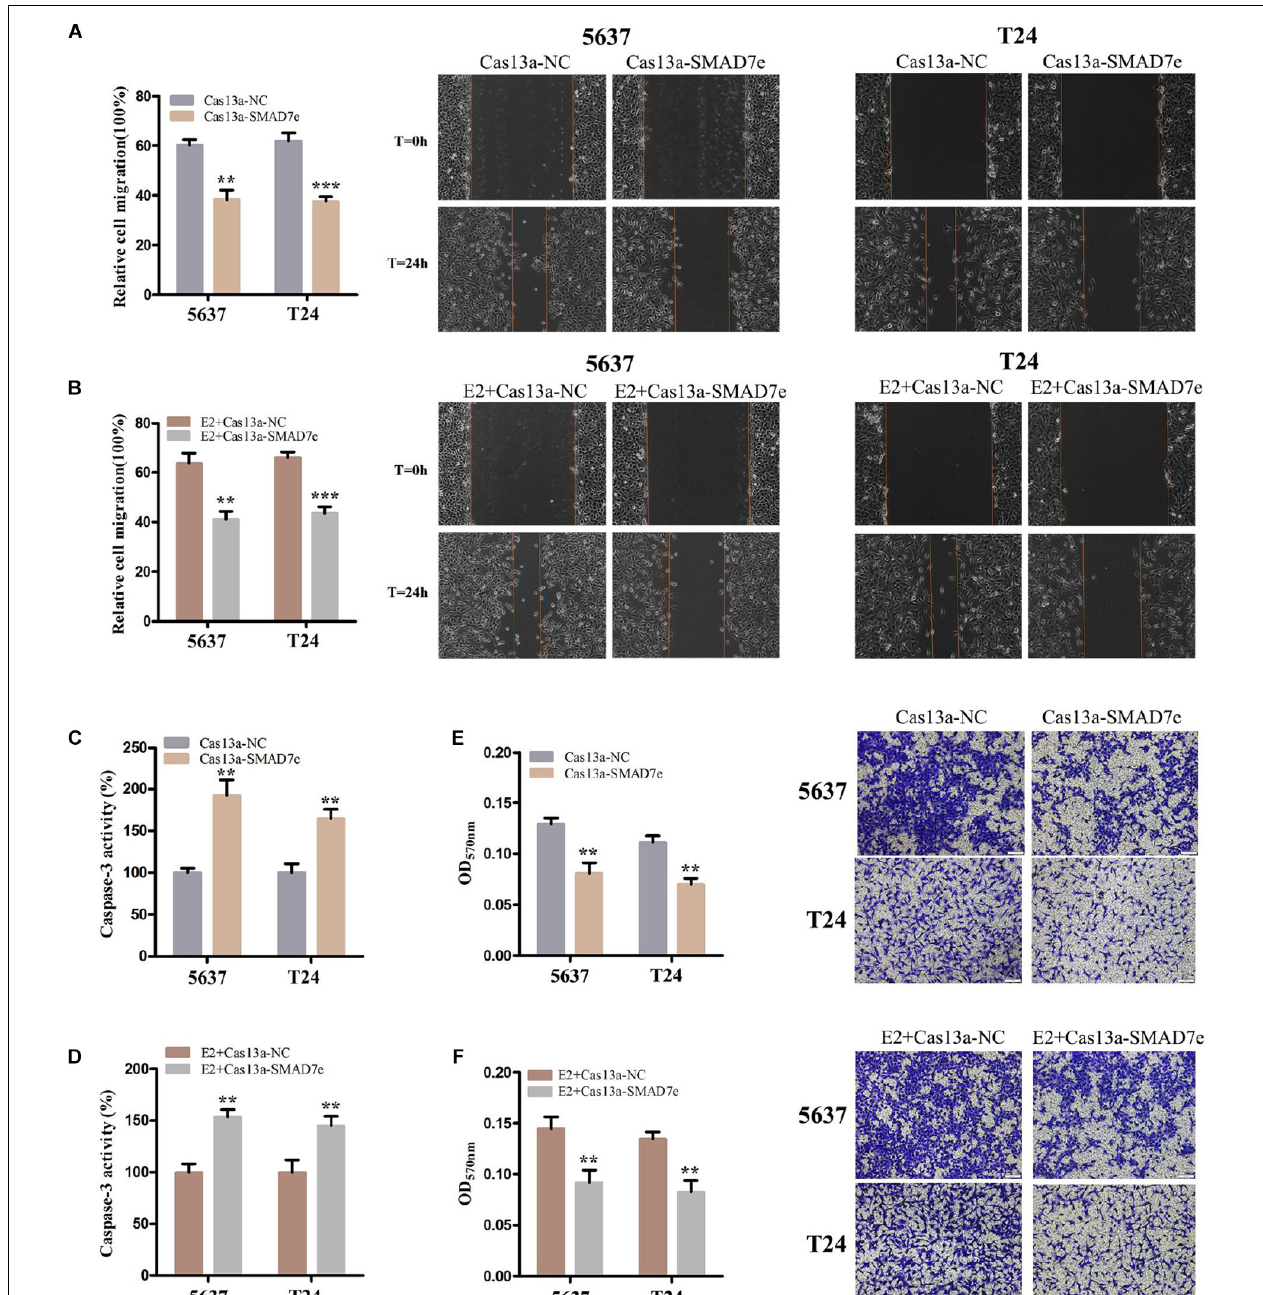
FIGURE 4 | The effect of Cas13a-SMAD7e on the migration of E2-treated bladder cancer cells. (A,B) Cell migration was detected by wound healing assays. SMAD7e knockdown inhibited migration of bladder cancer cells induced by estrogen. (C,D) The effects of knockdown of SMAD7e and SMAD7e knockdown with estrogen treatment were measured by caspase 3 ELISA assays. (E,F) Knockdown of SMAD7e and downregulation of SMAD7e attenuated estrogen-induced invasion of bladder cancer cells. E2 represents estrogen. Data are shown as the mean ± SD (** p < 0.01, *** p < 0.00).